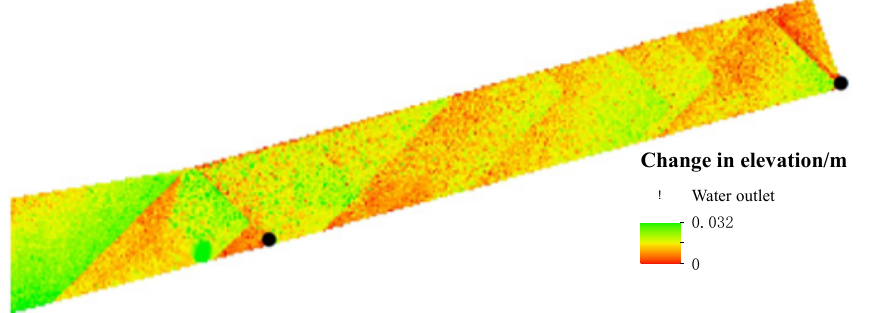
Figure 12. Difference between the modified DEM and the original DEM.